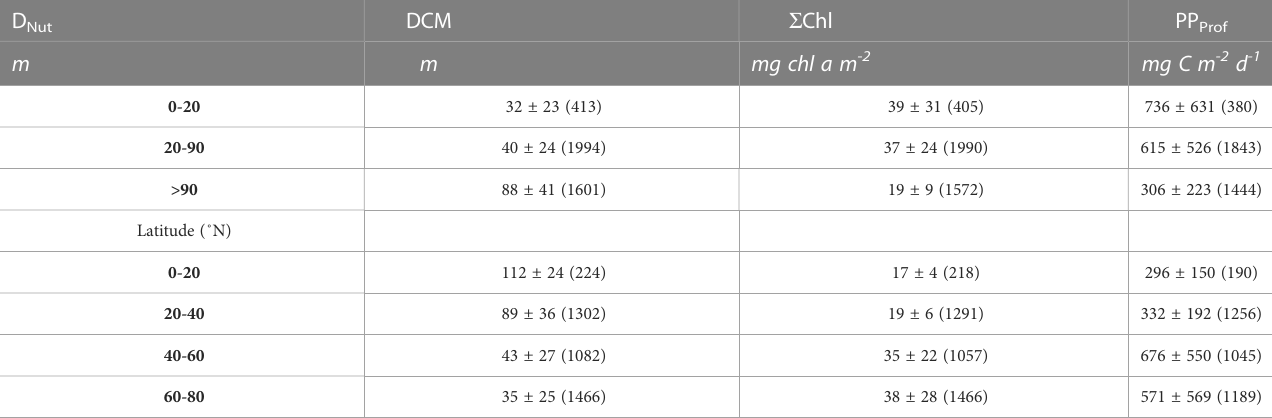
TABLE 2 Average values of all pro fi les (average ± std.dev, number of pro fi les in parenthesis) of the depth of the deep chlorophyll a maximum (DCM), vertically integrated chlorophyll a ( S Chl) and primary production calculated from Argo pro fi les (PP Prof ). D